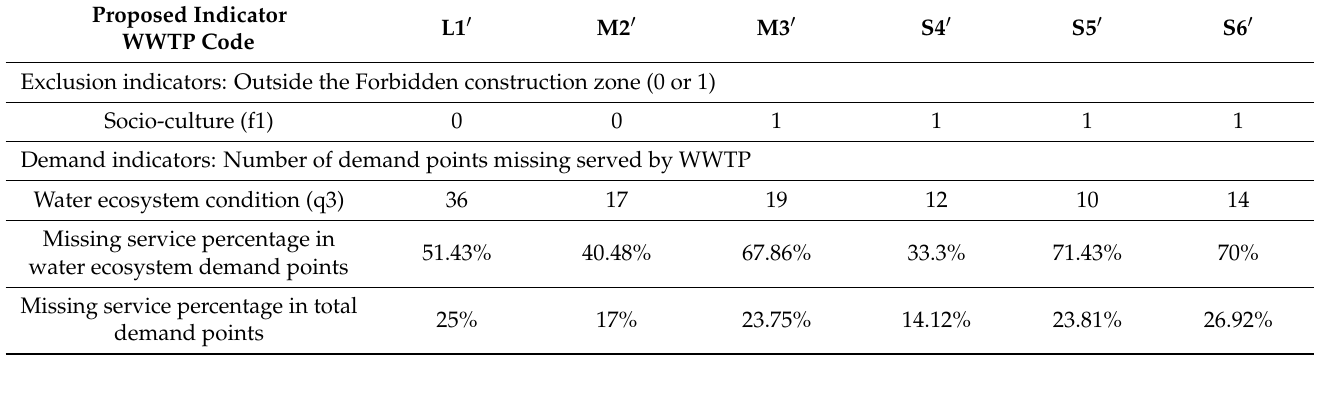
Table 9. Results without considering the indicator system.